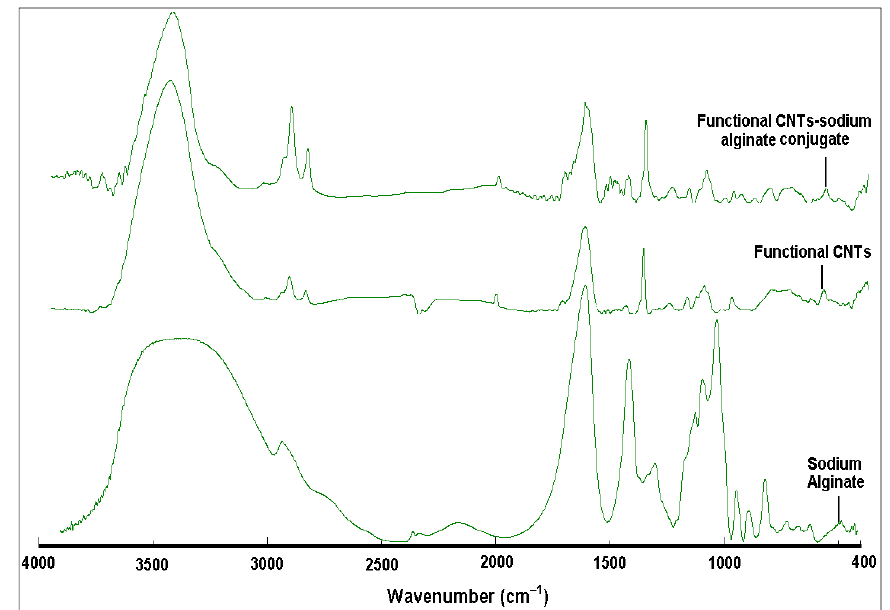
Figure 2. Fourier transform infrared (FTIR) spectra of sodium alginate, functional CNTs and functional CNT-sodium alginate conjugate. Table 2. Characteristic Fourier transform infrared (FTIR) peaks of functional CNTs and functional CNT-sodium alginate conjugate.